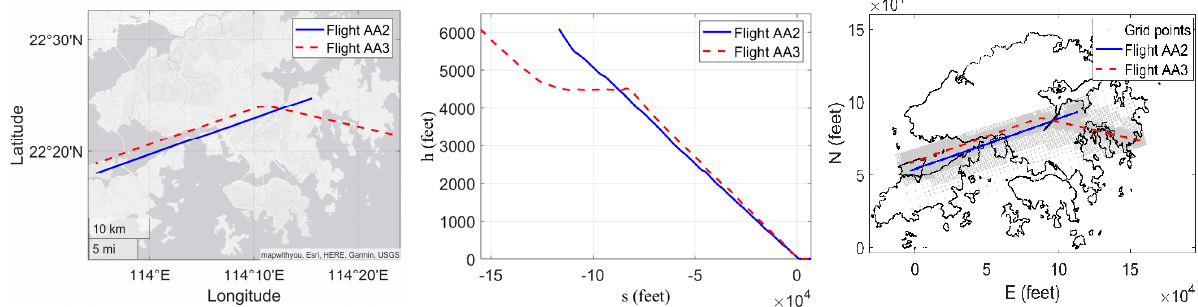
Figure A8. A330 aircraft approaching HKIA. Flights AA2 and AA3 respective routes (left: ground track, center: flight profile) and corresponding ground observers (dynamic grid, right).